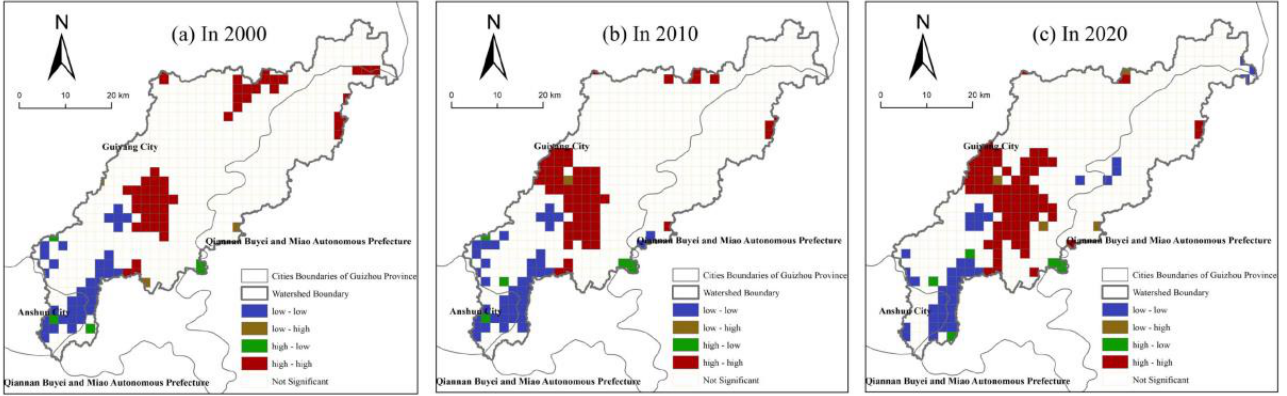
Figure 9. ( a ) LISA Map of Landscape Ecological Security in 2000; ( b ) LISA Map of Landscape Eco- logical Security in 2010; ( c ) LISA Map of Landscape Ecological Security in 2020.